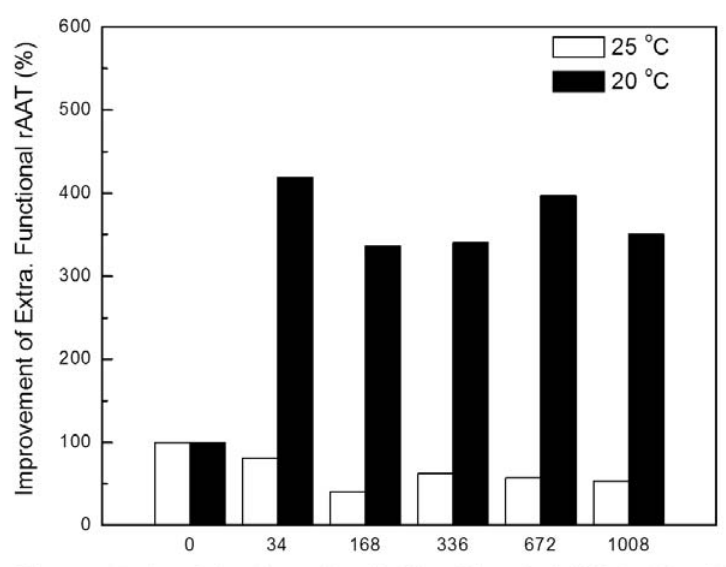
Figure 1. The effect of biomass ratio (0, 34, 168, 336, 672 and 1008 μ g ‐ DCW bacterial cell/g ‐ DCW plant cell) of Agrobacterium (P19) to suspended transgenic plant cells (CMViva) co ‐ cultivated in a 6 well ‐ microplate on the improvement of functional rAAT protein production at 20 °C or 25 °C. DCW stands for dry cell weight. Transgenic CMViva cell culture without the co ‐ cultivation of recombinant Agrobacterium was used as the control. Samples were taken on day 6 post ‐ induction.